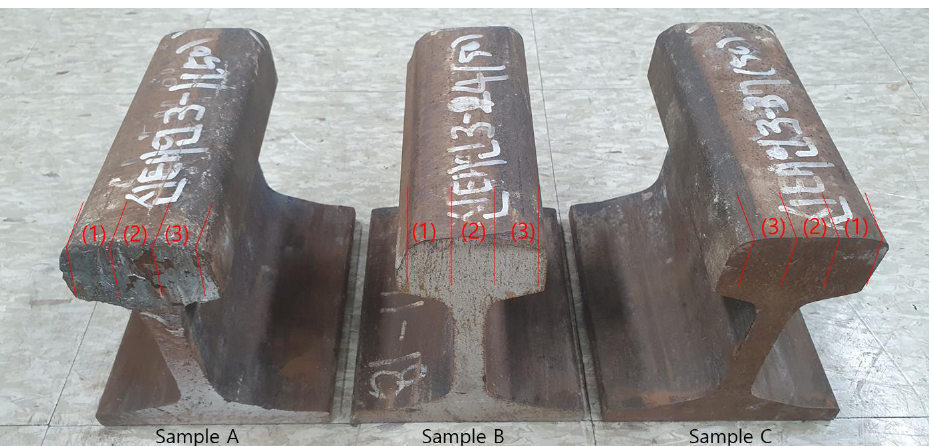
Figure 4. Photograph of three used rail specimens applied in experiments to measure residual stresses by magnetic Barkhausen noise.